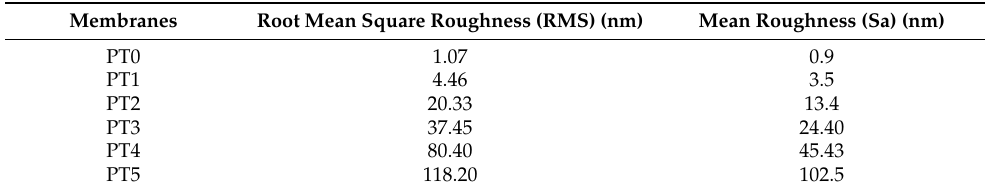
Table 3. Surface roughness parameters at different TiO 2 loading on the PVDF membranes obtained from AFM images (Figure